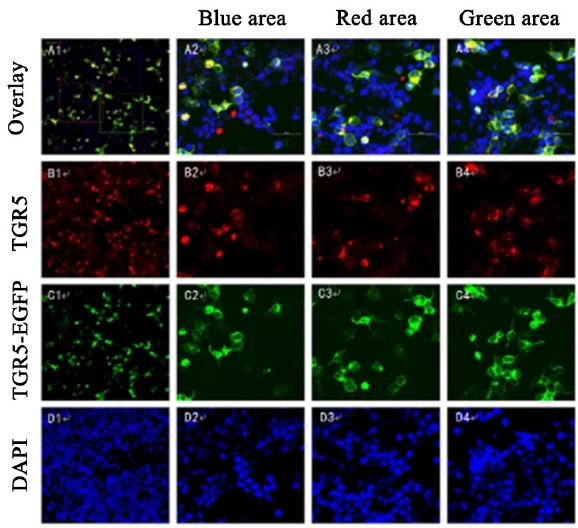
Figure 3. The expression and localization of TGR5 receptors were observed by immunofluorescence confocal microscopy. The red fluorescence overlay formation of yellow light distribution in the membrane and nuclei were stained blue with yellow around the blue, indicating receptor TGR5 in the 293T cells expressing it ( A1 – A4 ); TGR5 antibody-binding receptors present red fluorescence on the cell membrane ( B1 – B4 ); the 293T cells stably transfected with the pCMV-EGFP-TGR5 plasmid on the cell membrane ( C1 – C4 ); fluorescent dye DAPI and nuclear binding shown in blue ( D1 – D4